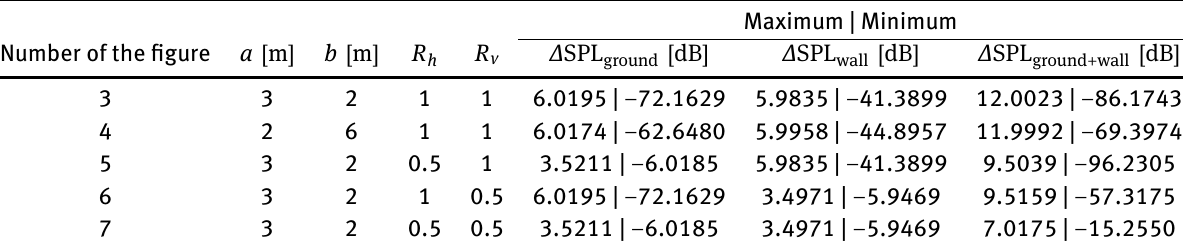
Table 4: Maximum increase or decrease of the sound power level (SPL), for a certain frequency, due to reflections on the ground and wall of the wave originated from the source at ( x , y ) = (700, 30) m , for the cases of Figures 3 to